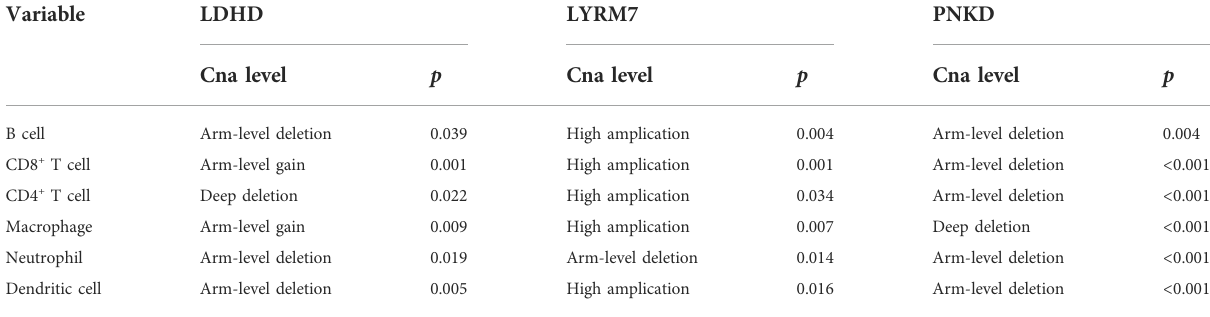
TABLE 1 Major mutation types affecting cell in fi ltration.